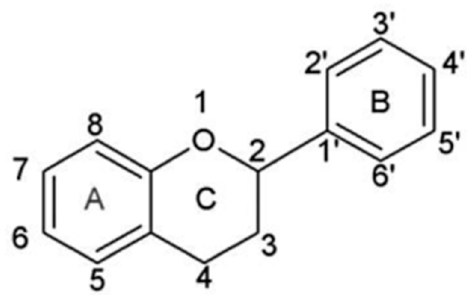
Figure 3. Basic flavonoid structure.